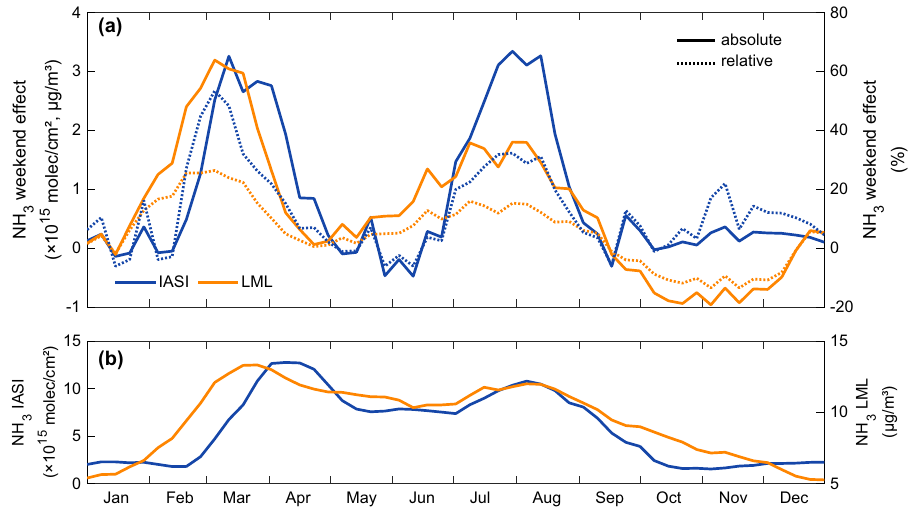
− 3 − 2 and μg m ) and relative (dashed lines,%) ◦ ◦ ◦ ◦ N–55 N; 2 E–15 E) and the National Air Quality − 2 15 molec cm ) − 3